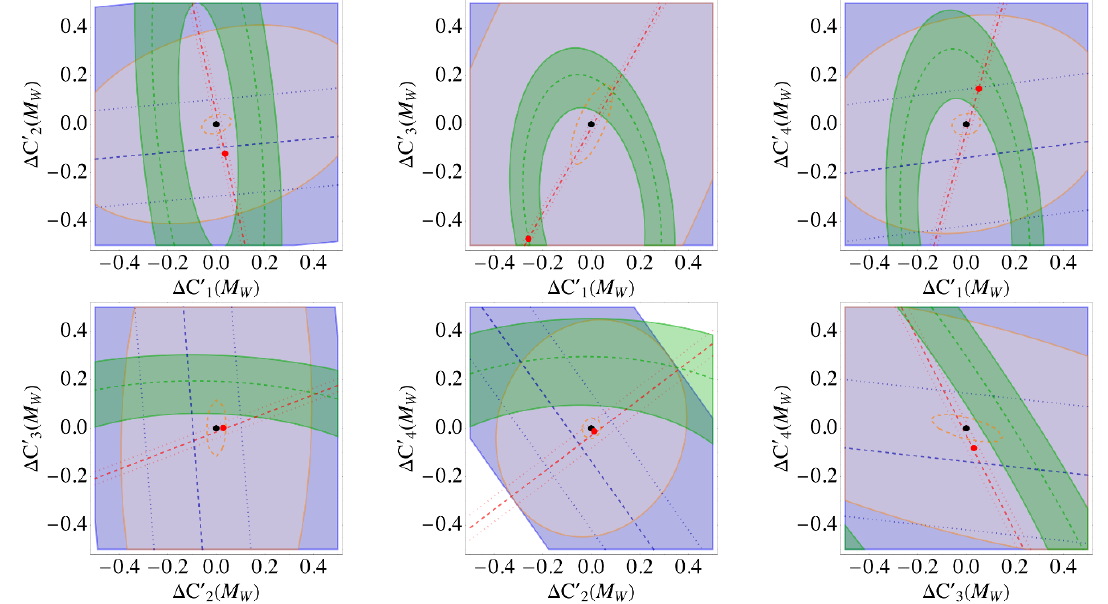
Figure 3. Contours of C 0 e(cid:11) ; BSM dashed), along with radiative decay (blue), lifetime ratio (green) and width di(cid:11)erence (orange) 1 (cid:27) constraints upon two parameter scenarios involving Wilson coe(cid:14)cients (cid:1) C 0 and best (cid:12)t point are shown as the black and red dots